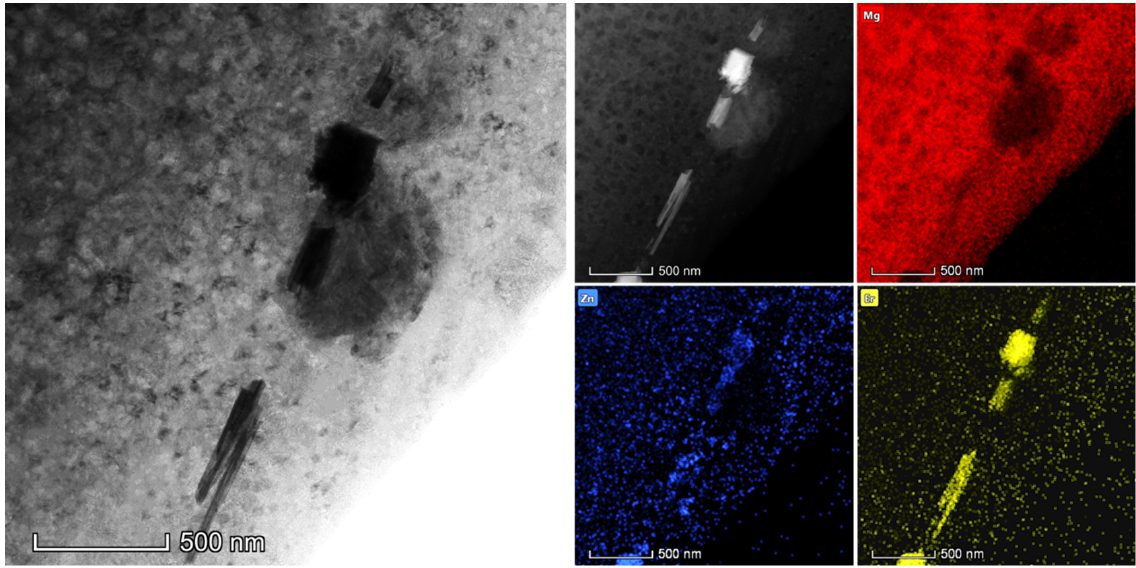
Figure 5. Mapping of the fragmentized primary second phase.